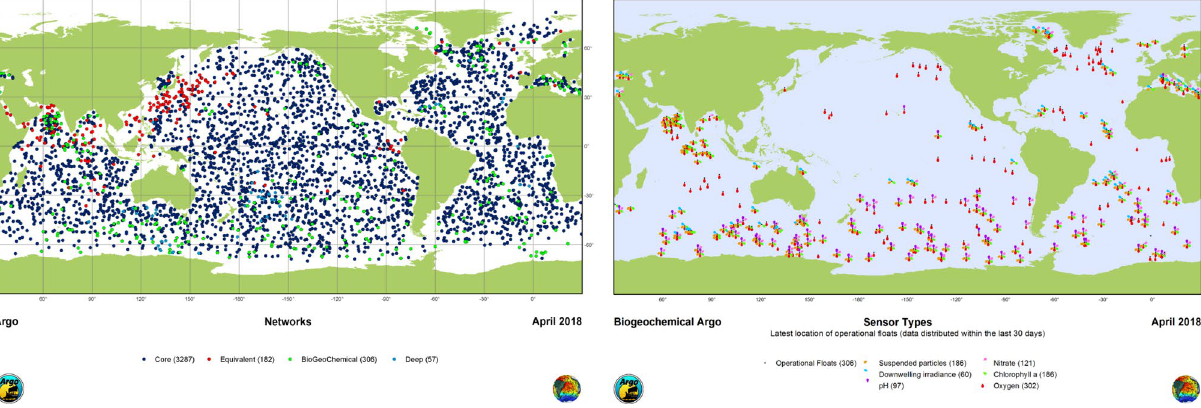
Fig. 8 Distribution of sensorised floats monitoring the status of a variety of ocean parameters that encompass core parameters (tempera- ture, velocity/pressure, salinity) and biogeochemical sensing (e.g., oxygen, nitrate, chlorophyll, pH). Reproduced with permission from